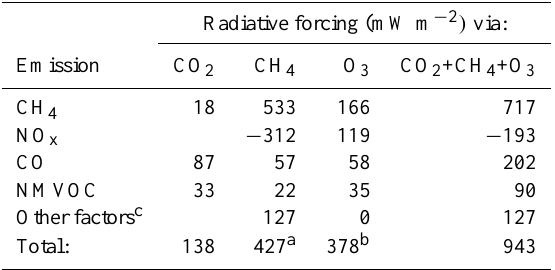
Table 9. Emission-based RFs (for 1850s–2000s) (via changes in CO 2 , CH 4 and tropospheric ozone) for emitted CH 4 , NO x , CO, and NMVOC, based on the mean response of the six models that conducted the attribution experiments (cf. IPCC-AR4 Table